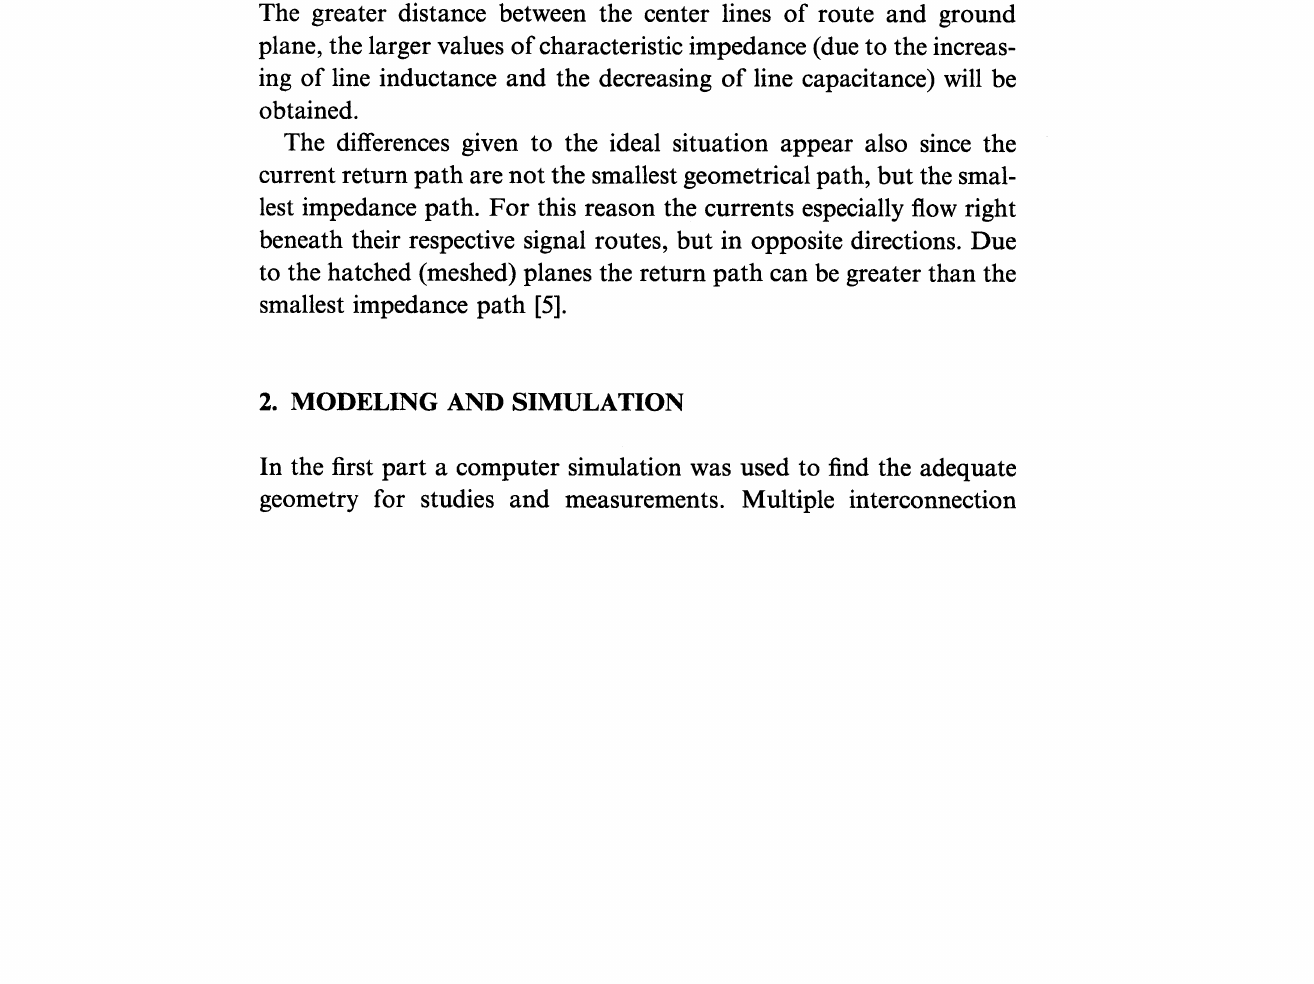
FIGURE Track above a hatched ground